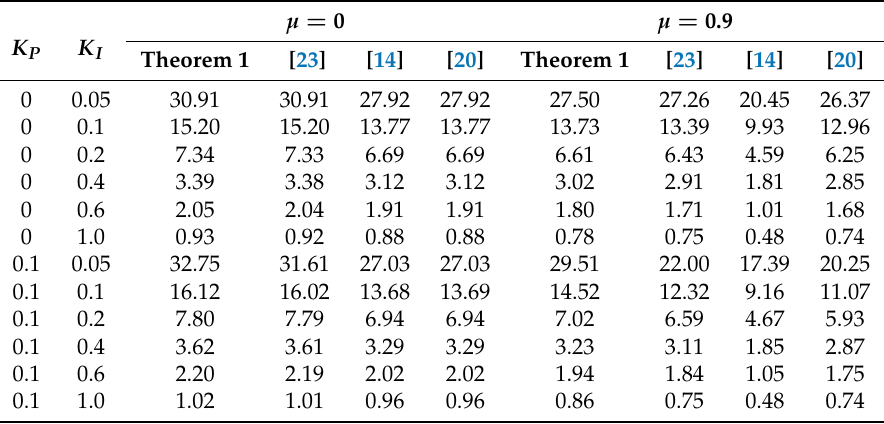
Table 2. Delay margins h for the traditional one-area LFC